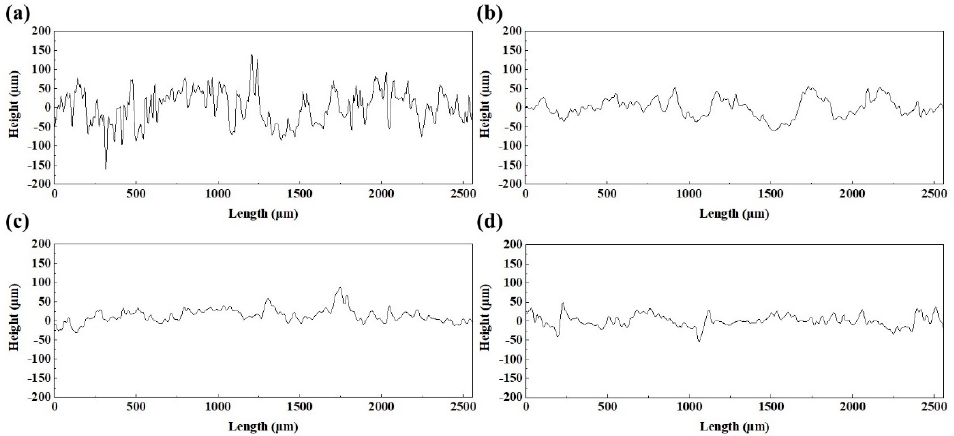
Figure 9. The surface profiles were obtained along the x-direction on the surface in Figure 8: ( a ) 95 W, 500 mm/s, scan I; ( b ) 125 W, 370 mm/s, scan I; ( c ) 215 W, 370 mm/s scan I; ( d ) 215 W, 370 mm/s, scan